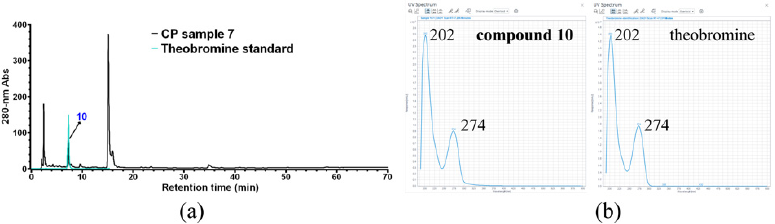
Figure 9. Identification of CP compound 10. ( a ) HPLC overlay chromatogram of CP sample 7 and theobromine standard; ( b ) UV ‐ vis spectrum analysis of compound 10 and theobromine standard.